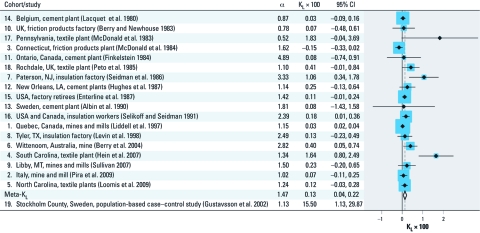
Forest plot with KL × 100 values (closed diamonds) and 95% CIs (lines) of included studies (for study numbers and details, see Table 1). The size of each square is proportional to the weight the study received in the meta-analysis. The open diamond denotes the meta-KL. Intercepts (α), KL values, and 95% CIs are listed. For scaling purposes, study 19 (Gustavsson et al. 2002) is not displayed in the plot.